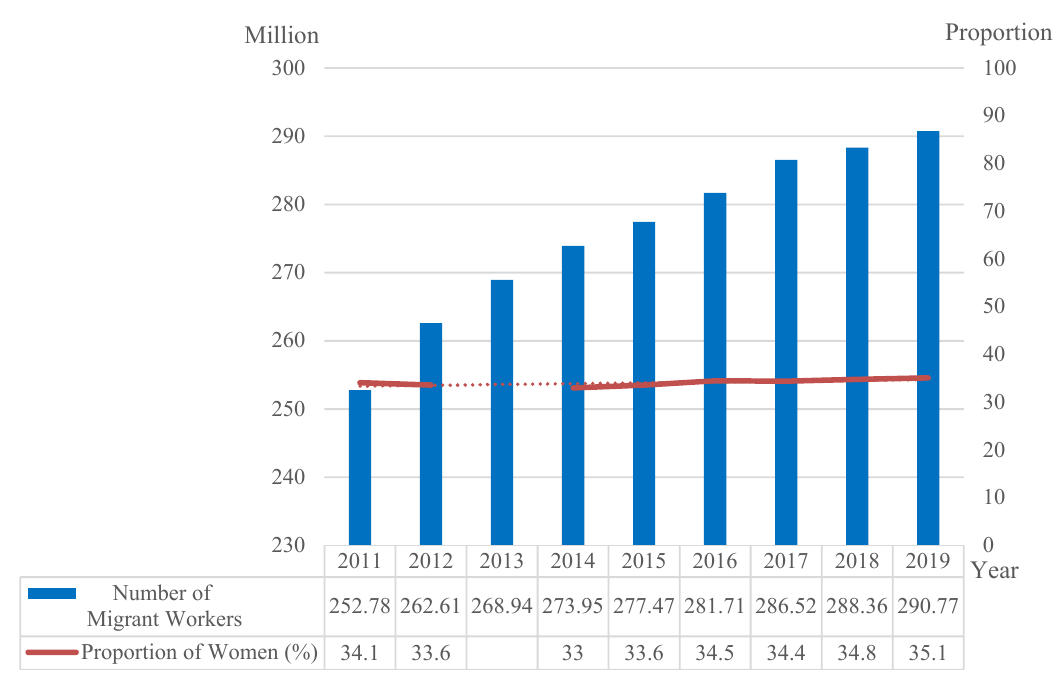
Figure 1. Number and gender distribution of migrant workers in China from 2011 to 2019 (Data source: National Bureau of Statistics. Note: Since the ratio of male to female migrant workers in 2013 is not released by the National Bureau of Statistics, the trend line is used instead here).